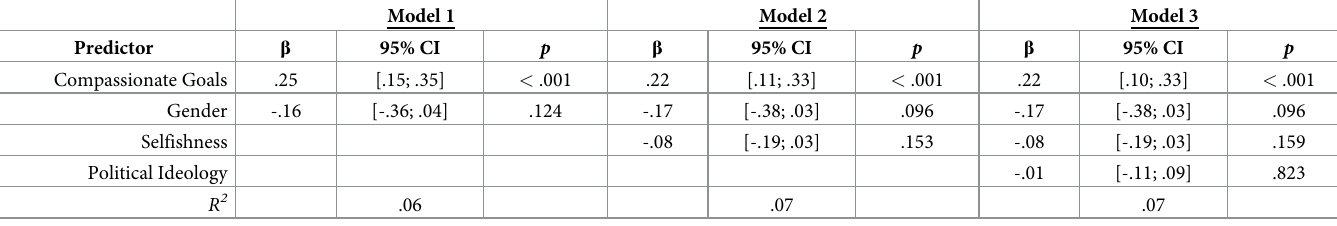
Table 4. Coefficients from multiple regression models predicting general health behaviors in Study